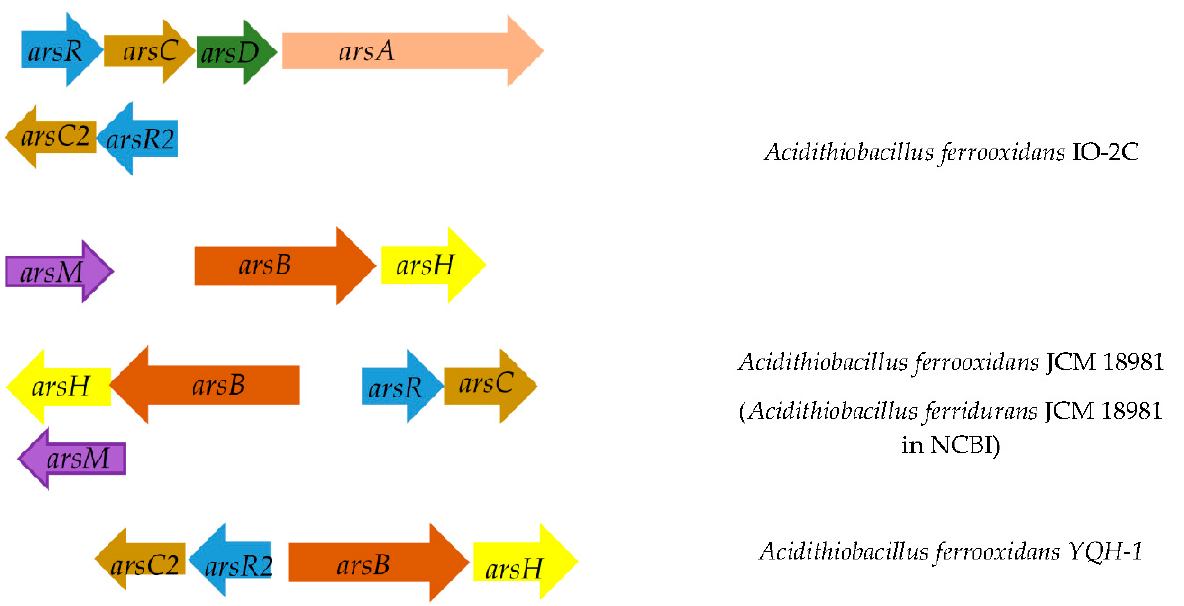
Figure 2. Location of arsenic resistance genes on the chromosome in different strains of A. ferrooxidans . Below is the distance between genes. Genes encoding: ArsB, arsenite/antimonite: H + antiporter; ArsR, transcriptional repressor of the arsenic resistance operon; ArsC, arsenate reductase; ArsD, transcriptional repressor and arsenic metal chaperone. Table 3. Distribution of formate dehydrogenase and oxidative stress enzymes in strains of A. ferrooxidans